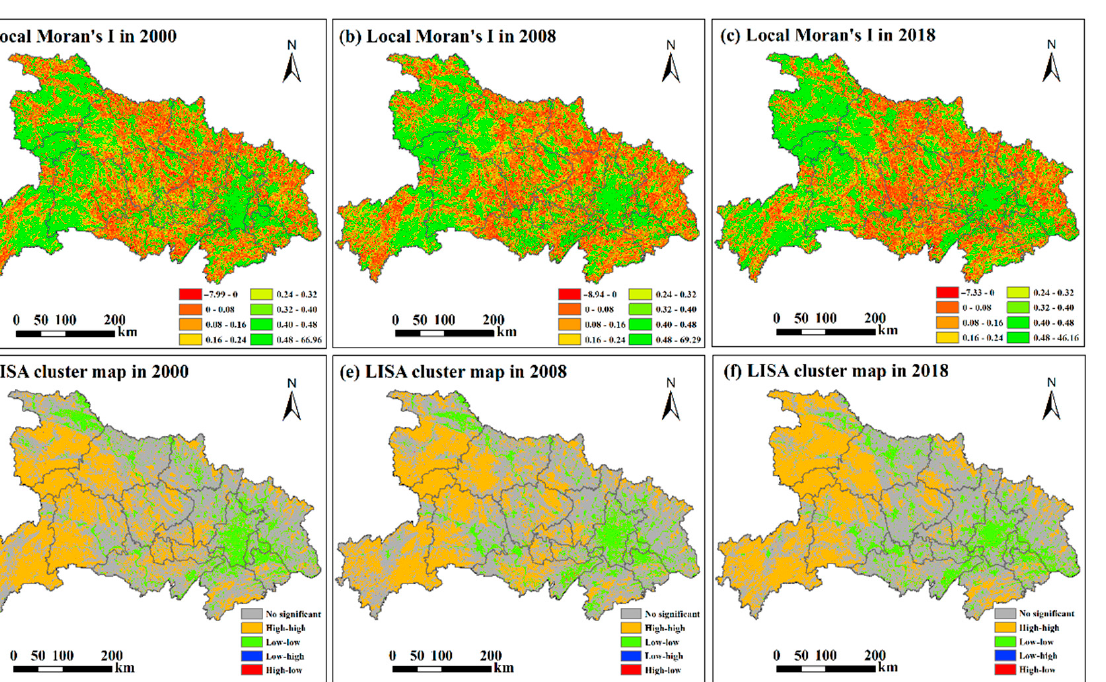
Figure 5. Mean value of NDVI ( a ) and global Moran’s I ( b ) between 2000 and 2018.